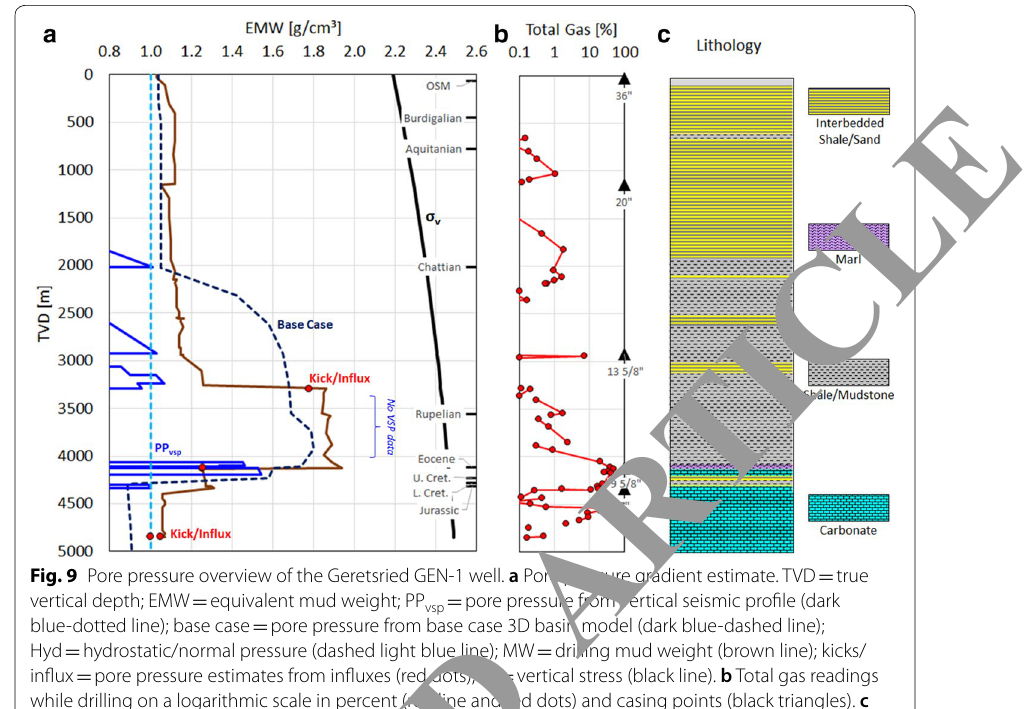
Fig. 9 Pore pressure overview of the Geretsried GEN-1 well. a Pore pressure gradient estimate. TVD vertical depth; EMW equivalent mud weight; PP vsp pore pressure from vertical seismic profile (dark = = blue-dotted line); base case pore pressure from base case 3D basin model (dark blue-dashed line); = Hyd hydrostatic/normal pressure (dashed light blue line); MW drilling mud weight (brown line); kicks/ = = influx pore pressure estimates from influxes (red dots); σ v vertical stress (black line). b Total gas readings = = while drilling on a logarithmic scale in percent (red line and red dots) and casing points (black triangles). c Simplified lithological